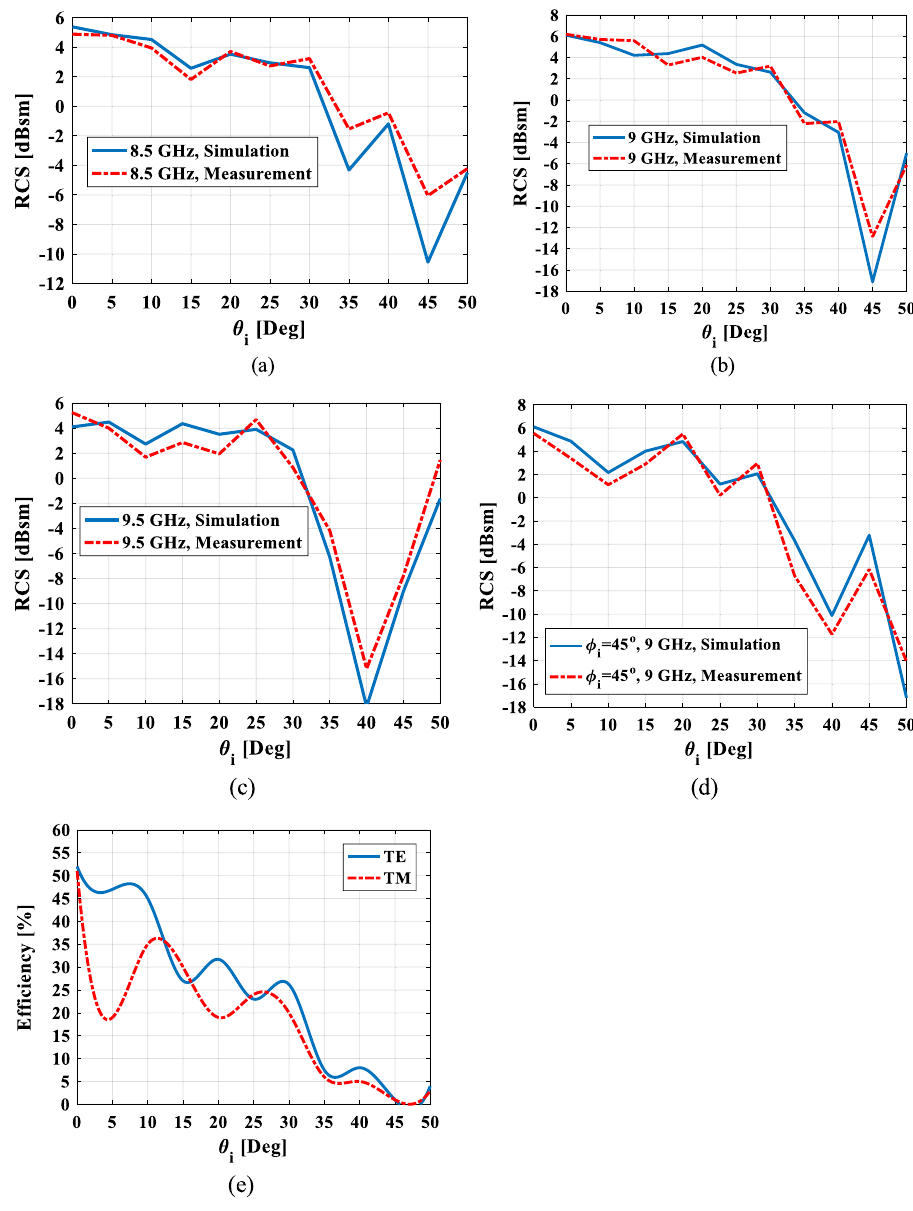
Figure 14. Simulation and measurement results of the proposed retroreflector at ( a ) φ i = 0 ◦ , f = 8.5 GHz, ( b ) φ i = 0 ◦ , f = 9 GHz, ( c ) φ i = 0 ◦ , f = 9.5 GHz, ( d ) φ i = 45 ◦ , f = 9 GHz, (e) measured efficiency as a function of incident angle at frequency of 9 GHz for TE and TM